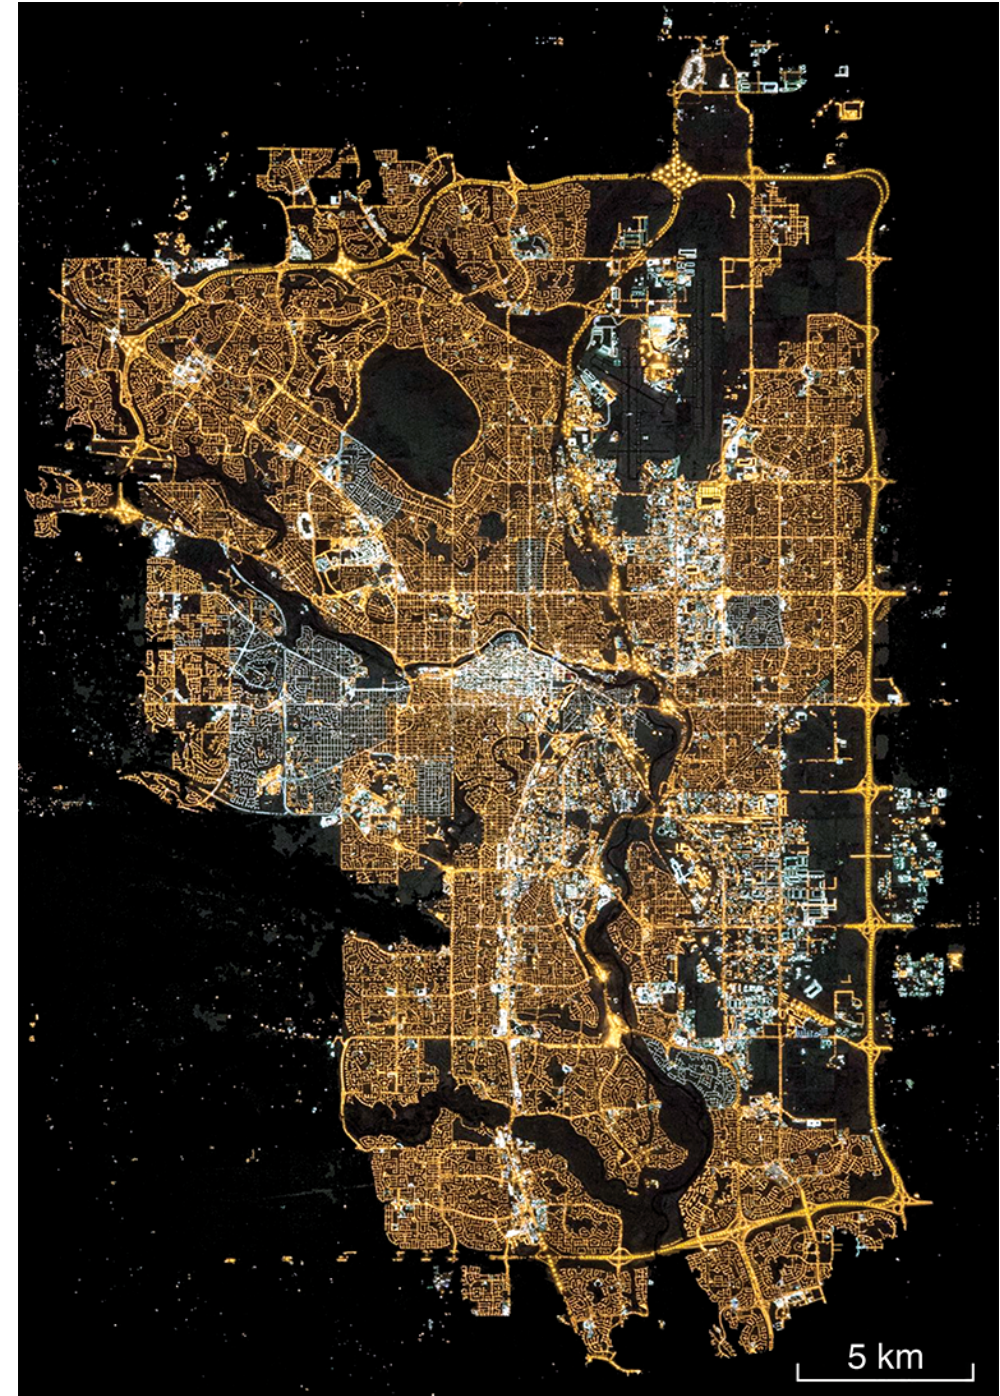
Figure 1. True-color image of the city of Calgary, Canada, obtained by an astronaut aboard the International Space Station at 0707 UTC (12:07 am local time) on 28 November 2015. The image is oriented north up and east at right. National Aeronautics and Space Administration photo